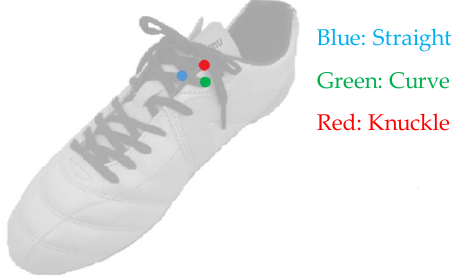
Figure 5. The mean coordinate value of impact point of each trial. Points of mean coordinate value of impact point are showed by color of blue, green and red respectively straight, curve and